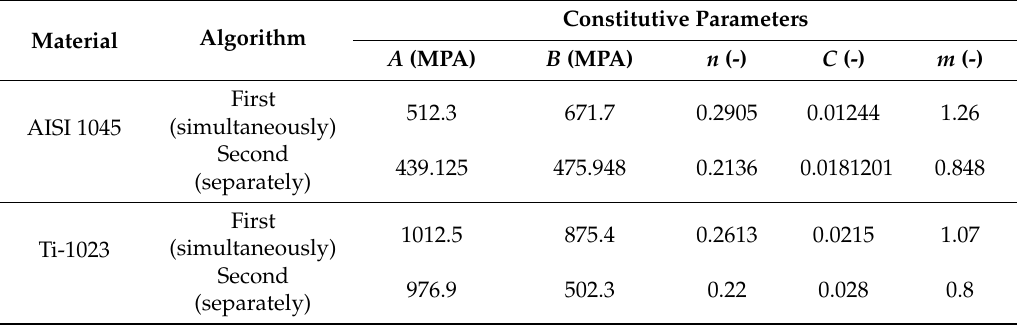
Table 2. Constitutive parameters as established with the second algorithm.